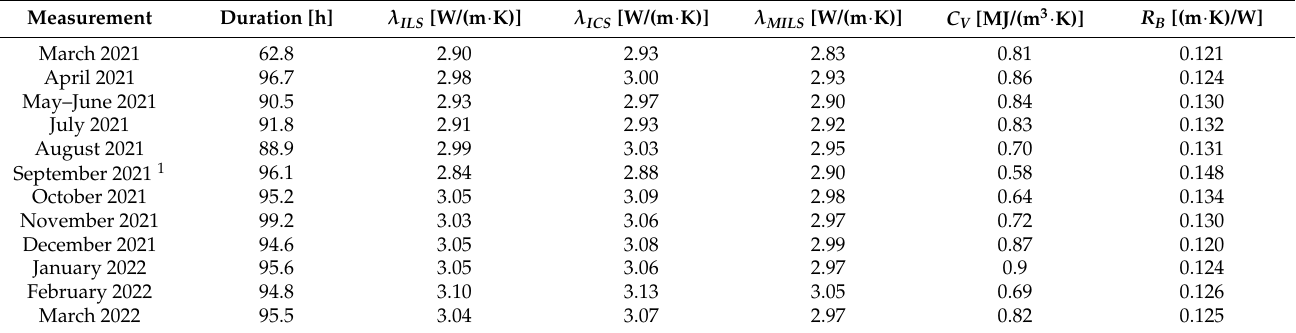
Table 2. Summary of duration and analysis results for thermal response tests using infinite-line-source (ILS), cylinder-source (CS), and moving-infinite-line-source (MILS) models.